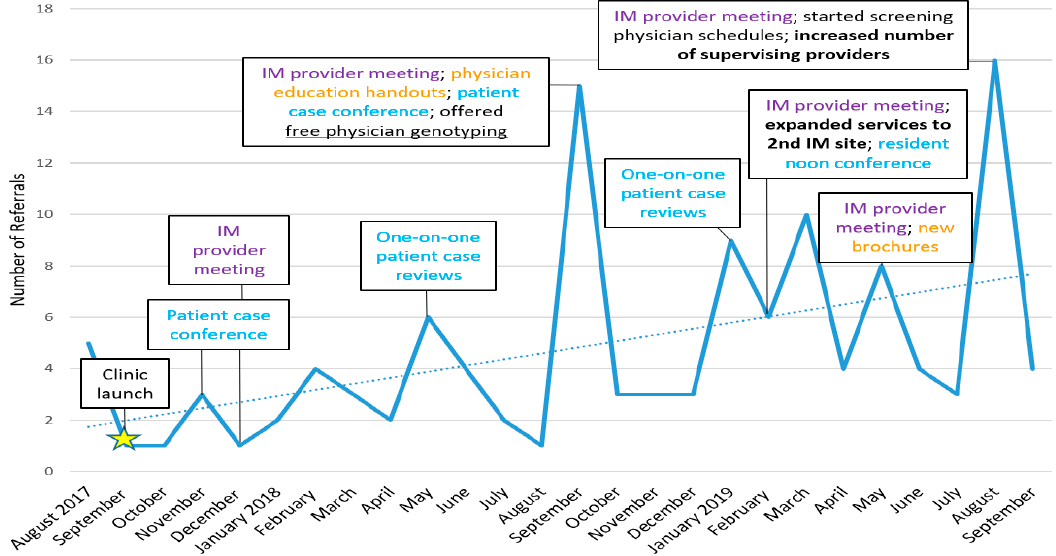
Figure 3. Number of referrals by IM physicians to the pharmacogenetics consult clinic per month, including captions of interventions taken to engage physicians and increase referrals. Similar colored captions indicate similar interventions. Dotted line indicates trend line. IM: Internal Medicine.